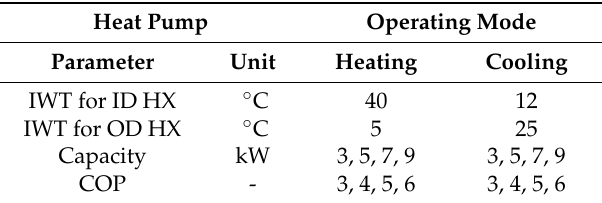
Table 2. Experimental test